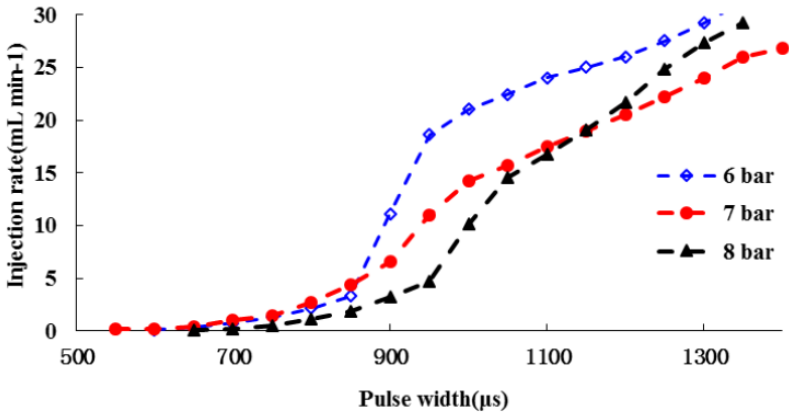
Figure 5. Injection rate of RRV under three air pressures, calibrated by using 10% LUVITEC ® solution.